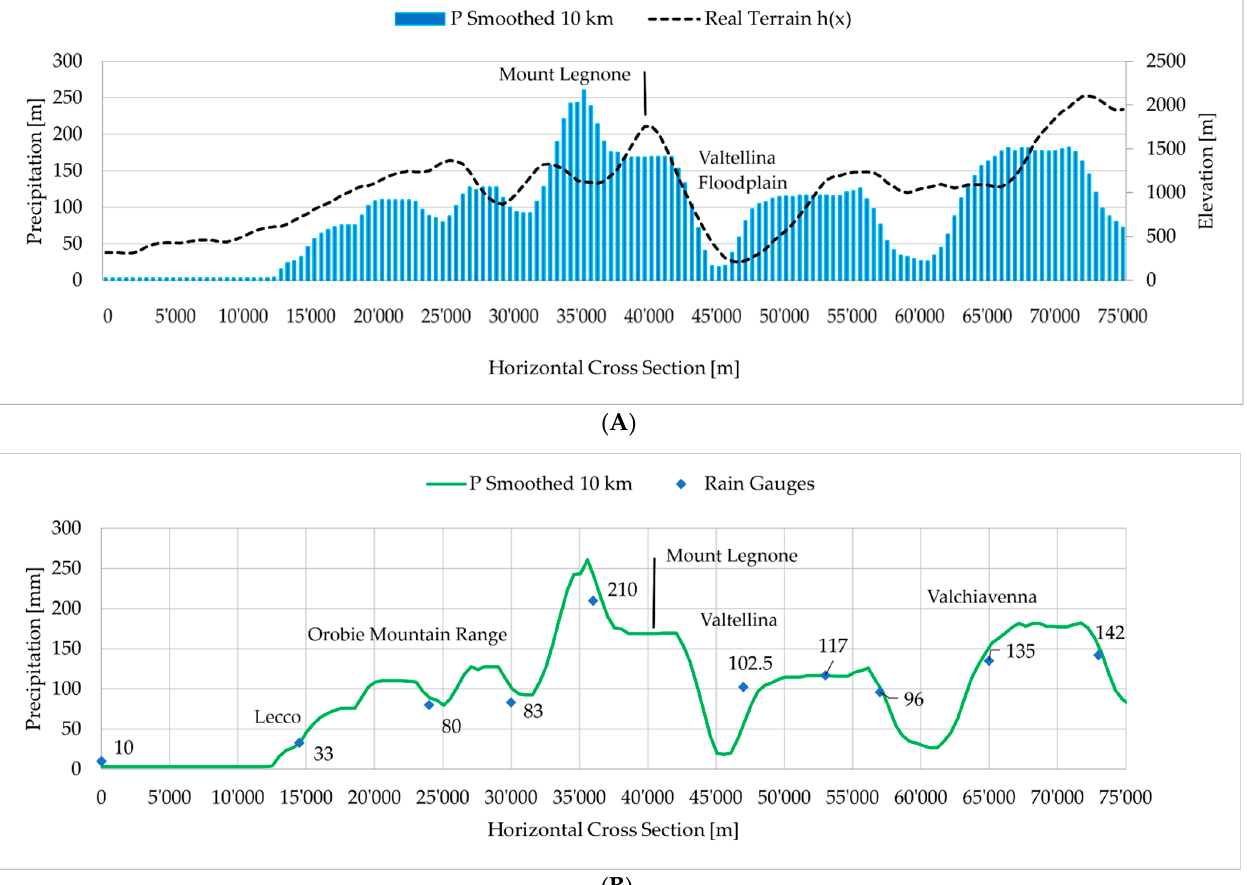
Figure 9. ( A ) The precipitation field is represented against the orography of the area and ( B ) is compared with respect to the rain gauge measurements.